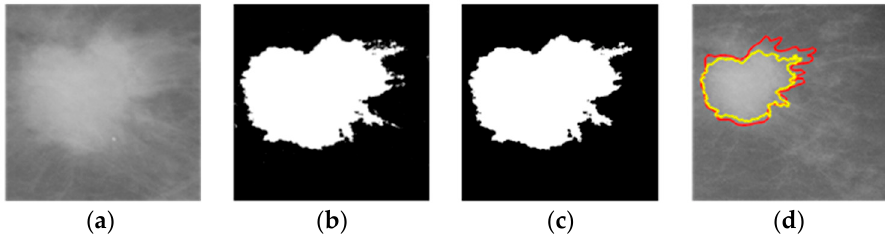
Figure 8. ( a ) Original ROI; ( b ) PCNN processing results; ( c ) detection results of removing isolated points; and ( d ) displaying the detection results on the original image.